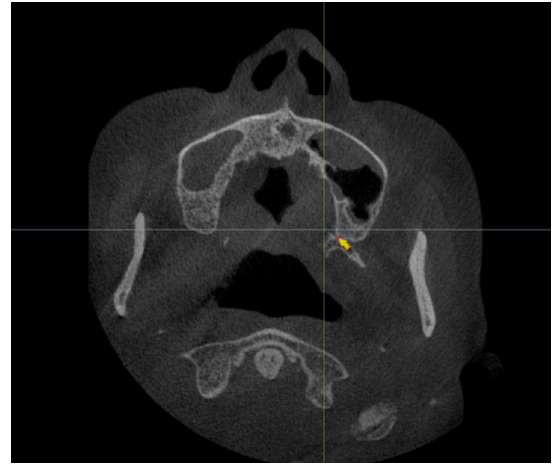
Fig. 2 The lowest point of the pterygoid maxillary junction was first recognized between the maxillary tuberosity and pterygoid process from the coronal plane in the software